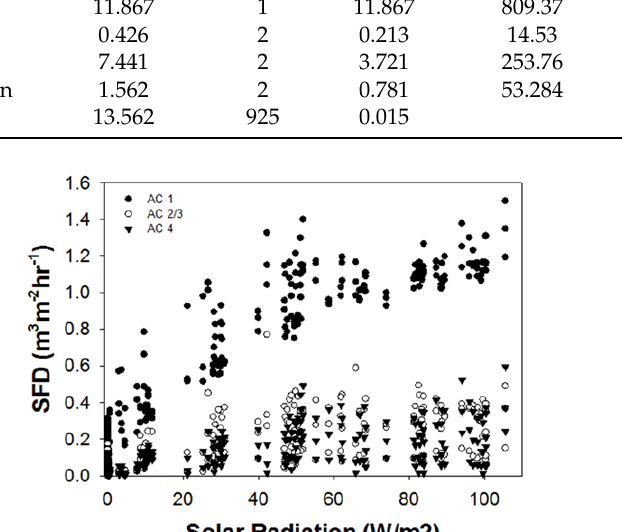
Table 2. Analysis of variance statistics for the main effects of ash canopy condition class, vapor pressure deficit (VPD), and radiation on ash tree sap flux (SFD) density rates. Figure 1. Sap flux density (SFD) of Fraxinus pennsylvanica trees during 26–30 June 2010 (AC1 = low infestation levels, AC 2 & 3 moderate infestation levels, and AC4 = high infestation levels). Error bars denote ±1 SE.